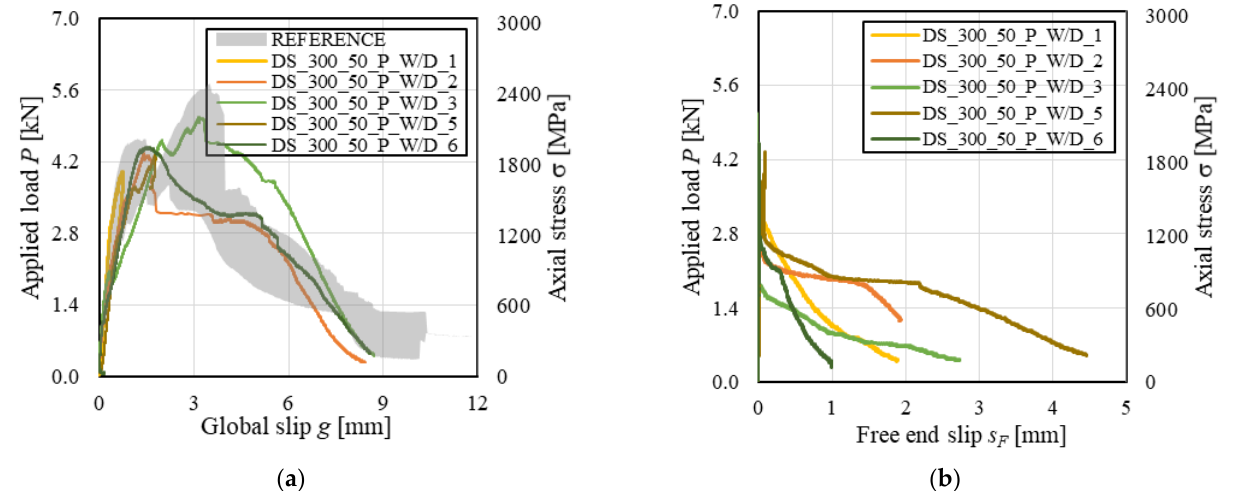
Figure 9. ( a ) P-g and ( b ) P-s F responses of FRCM-masonry joints with PBO fiber textile.